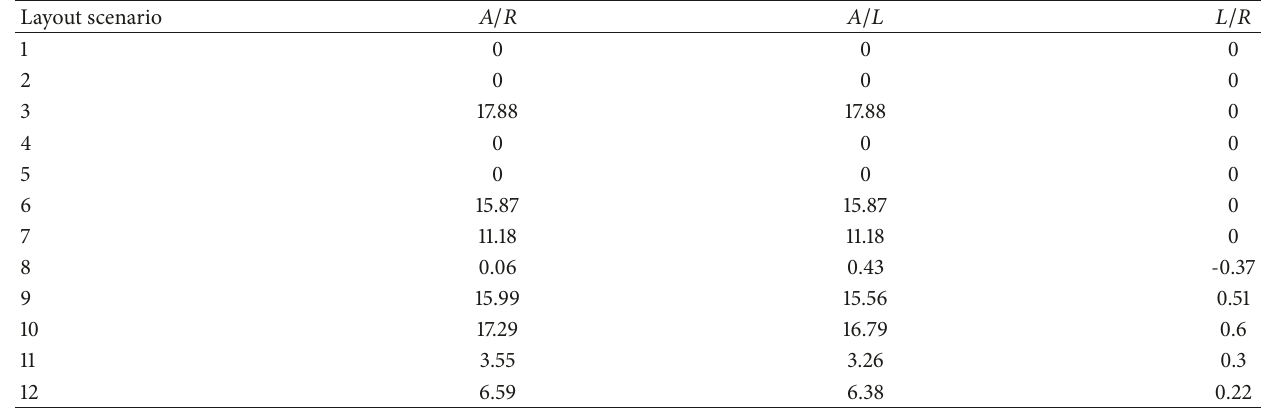
Table 4: The percentage differences between different methods (unit: